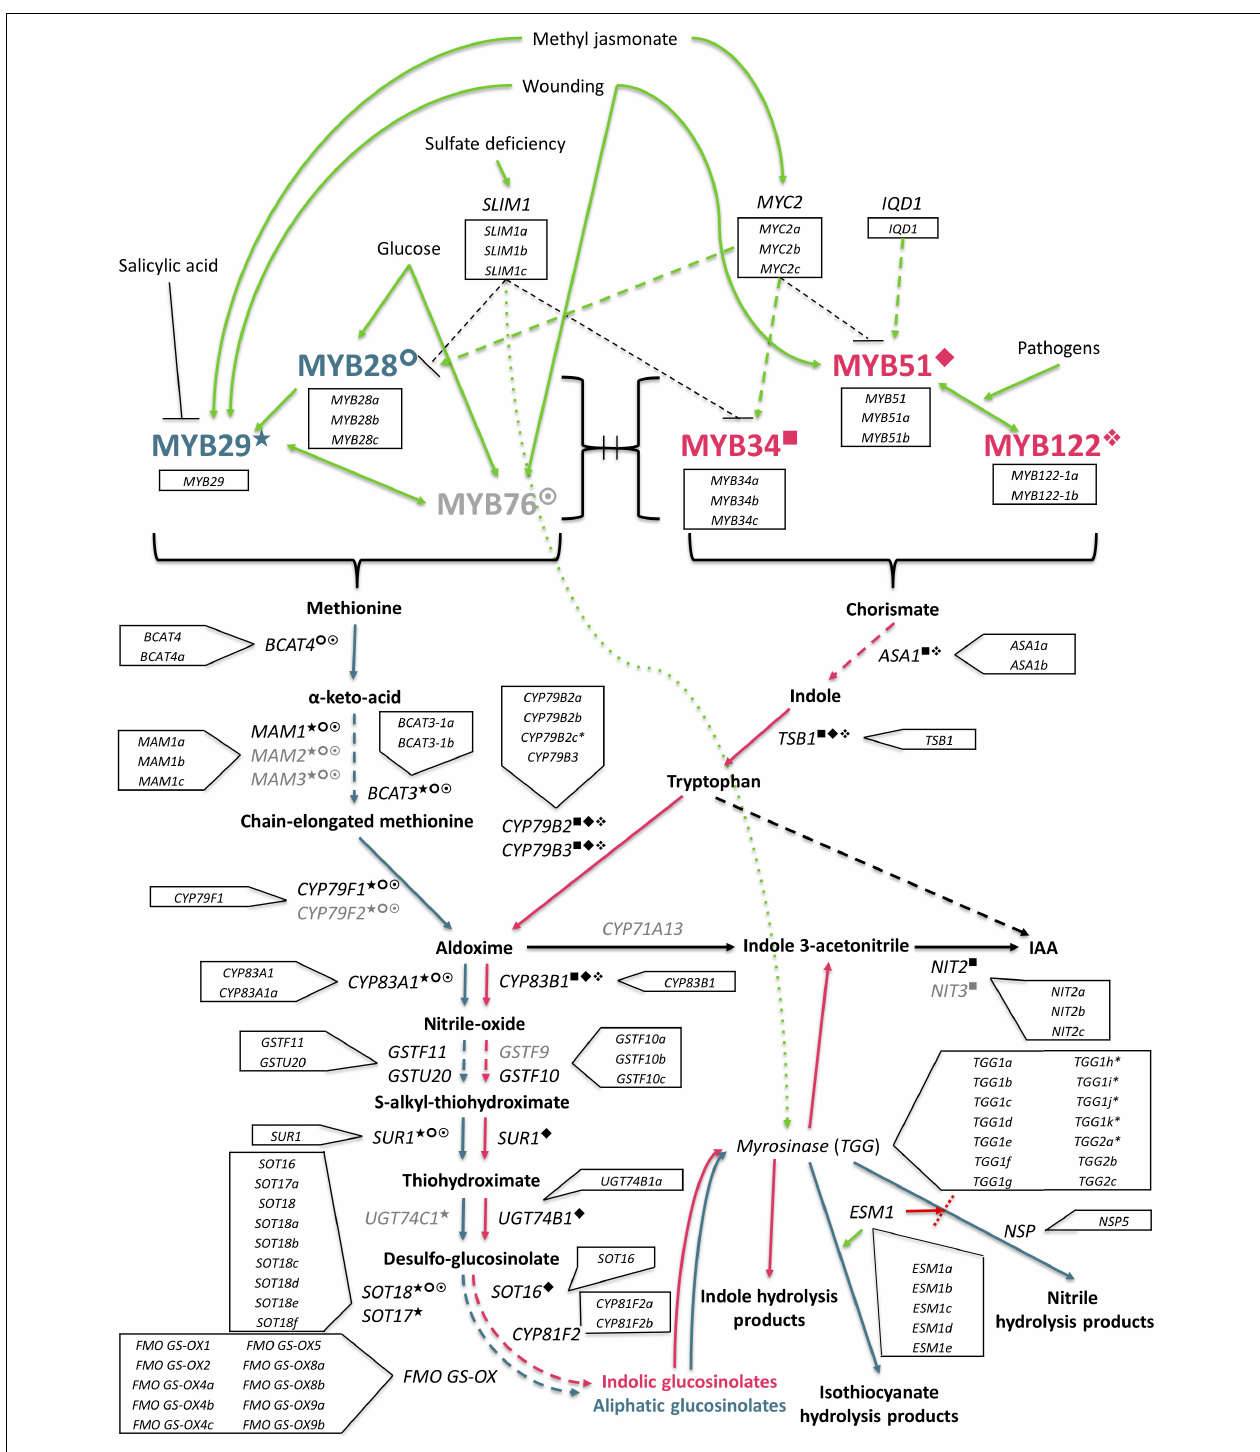
FIGURE 11 | The GSL biosynthesis pathway (adapted from Gigolashvili et al., 2009) is initiated by a complex and interacting network of abiotic and biotic factors. Aliphatic synthesis pathway shown in teal, and the indolic pathway shown in pink, is regulated by R2R3-MYB transcription factors. Known interactions between MYBs and specific genes within each respective pathway are highlighted as follows: MYB28; (cid:70) = MYB29; (cid:12) = MYB76; (cid:4) = MYB34; (cid:7) = MYB51; = MYB122. Genes with identified orthologs in the E. sativa genome annotation are written in black; those with no identified homologous sequence are written in gray. SLIM1, (cid:35) (cid:109) sulfur limitation 1 ; IQD1, protein IQ domain 1 ; BCAT, methionine aminotransferase ; MAM, methylthioalkylmalate synthase ; CYP, cytochrome P450 ; GST, glutathione-S-transferase ; SUR1, C-S lyase 1 ; UGT, UDP-glycosyltransferase ; FMO GS − OX , flavin-containing monooxygenase ; ASA1, anthranilate synthase alpha subunit 1 ; TSB1, tryptophan synthase beta chain 1 ; IAA, indole-3-acetic acid; NIT, nitrilase ; ESM1, epithiospecifier modifier protein 1 ; NSP, nitrile specifier protein .